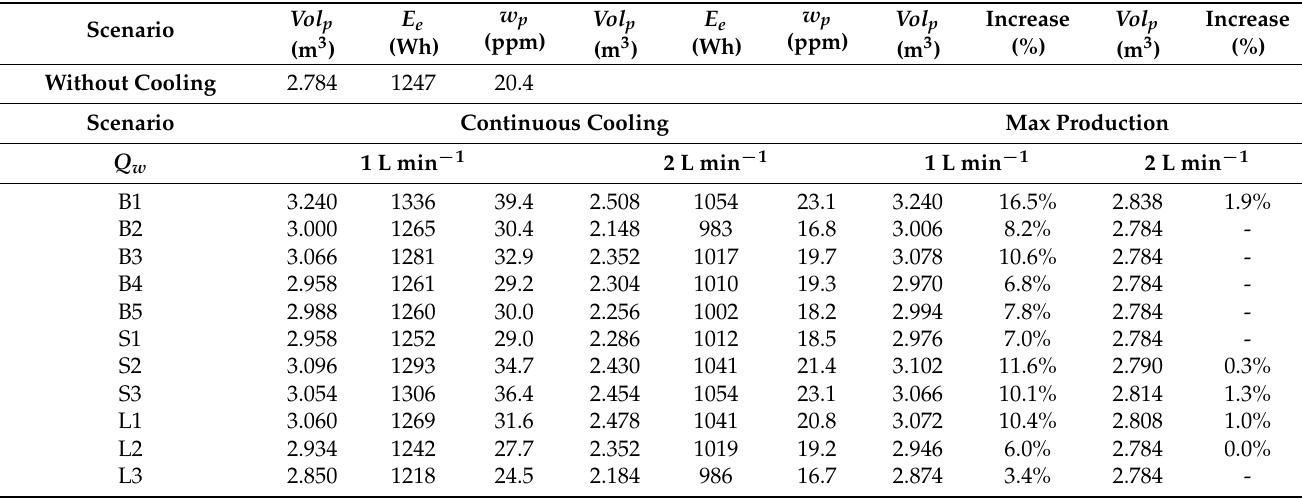
Table 6. Simulation results for PVT-RO hybrid system power generation and water production, based on weather data for 24 July